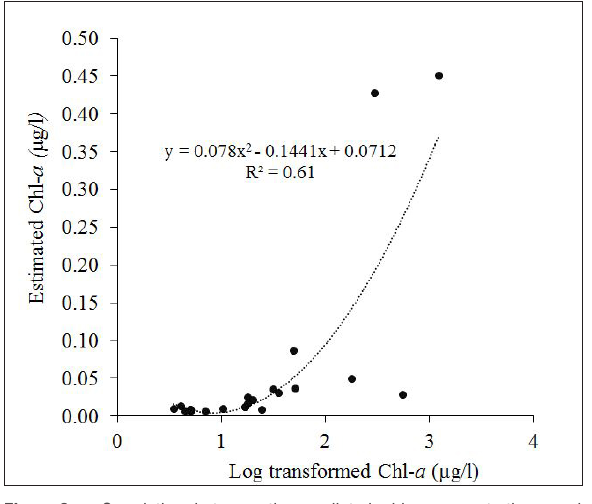
Correlation between the predicted chl- a concentrations and measured log-transformed chl- a concentrations within the Vaal